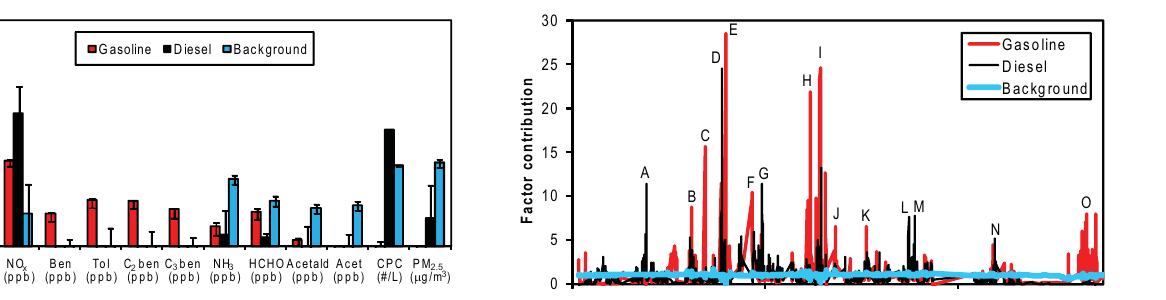
Fig. 3. Time series of PMF factor contributions; each series aver- ages to unity. Descriptions of the video at each labeled spike appear in Table